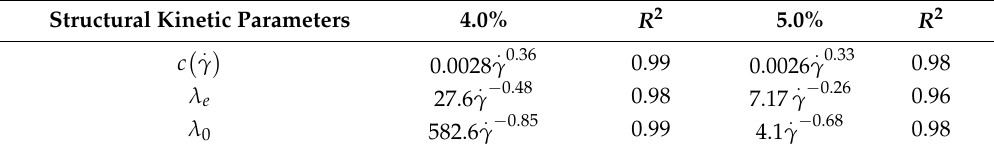
Figure 6. Viscosity of 4% “intact” gel as a function of time at different constant shear rates (50, 100, 500, and 1000 s − 1 ). Table 2. Structural kinetic parameters to describe viscosity time decay for 4% and 5% gels.